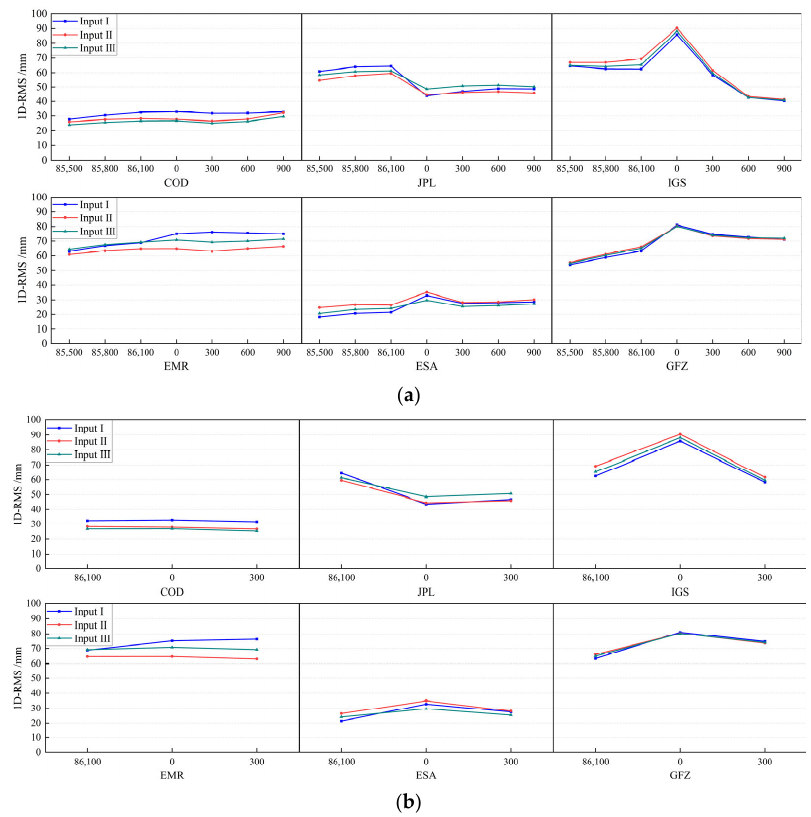
Figure 7. Time series near the daily boundary of dynamic LEO orbit (unit: mm). The horizontal coordinate is seconds in days and the vertical coordinate is 1D-RMS. ( a ) 15 min near the day boundary ( b ) 5 min near the day boundary.